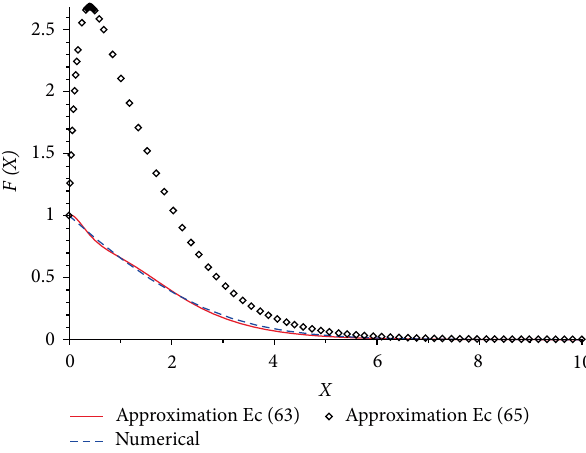
Figure 6: Comparison between numerical solution of (33) and approximations (63) and (65) for 휀 =